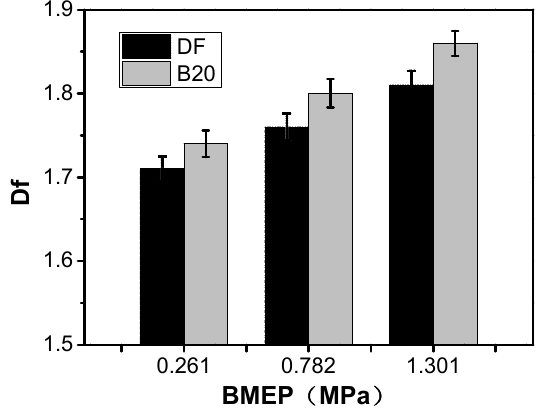
Figure 1. Fractal dimension (Df) values of soot particles as a function of BMEP.